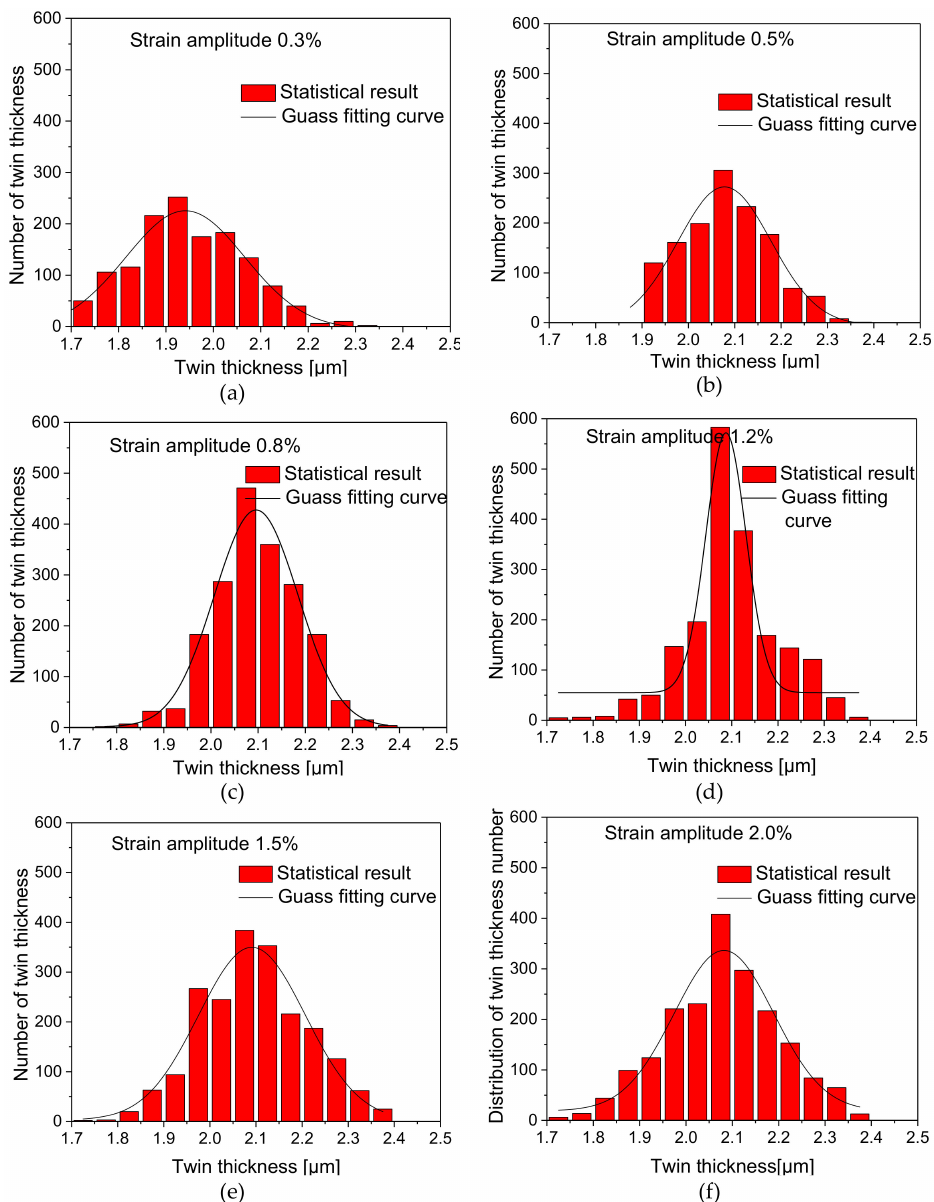
Figure 6. Distribution diagram of twin thickness corresponding to di ff erent strain amplitudes: ( a ) 0.3%; ( b ) 0.5%; ( c ) 0.8%; ( d ) 1.2%; ( e ) 1.5%; ( f )